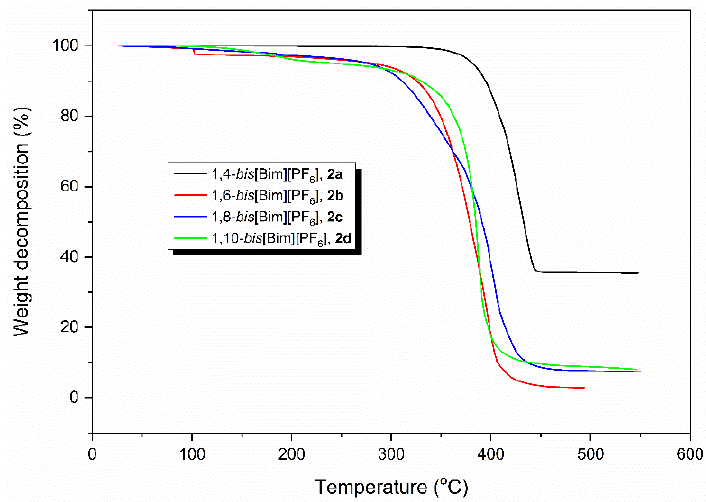
Figure 2. The TGA heating curves for the synthesized 1,n- bis [Bim][PF 6 ] ( 2a – 2d ) catalysts at a heating rates of 10 °C/min.